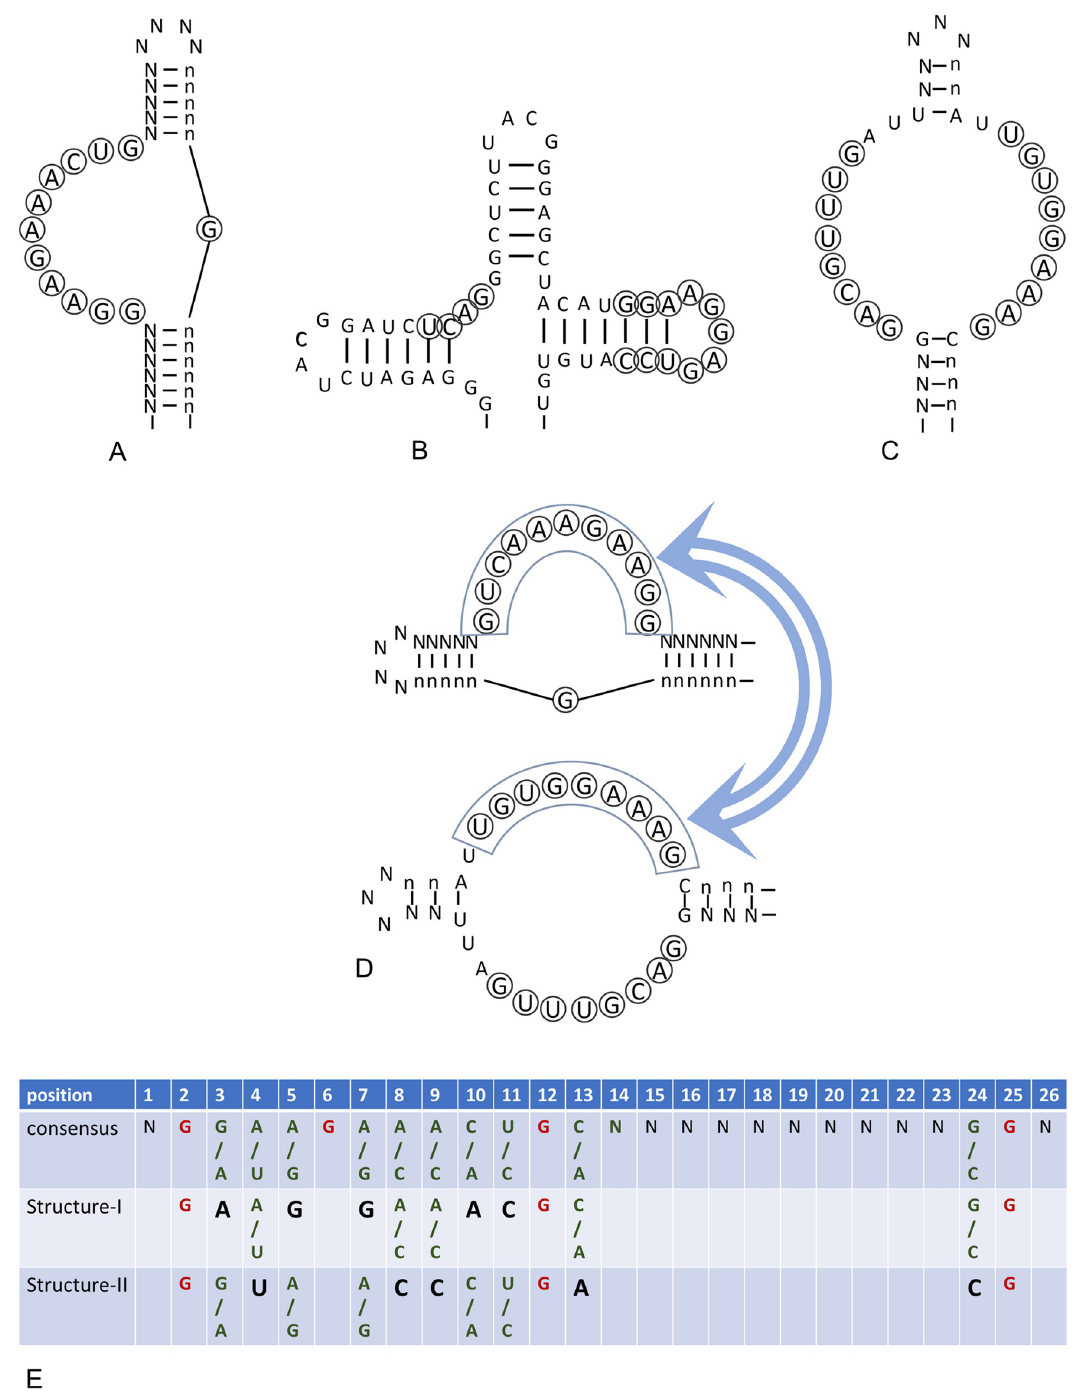
Fig 4. General idea of alternative structures of aptamers binding the same ligand and its specific implementation scheme for the BioRS function. (A-) Three structures of aptamers binding to ATP that differ in their sequence and secondary–tertiary structure. The first structure (structure-I) (Sassanfar-Szostak motif) we will name as a “rod” (A). Second structure (structure-II) will be referred to as a “cloverleaf” (B) [93]. () One more version of an aptamer binding ATP [92]. (D) Consensus sequences of (A) and (C), critical to the recognition and binding of a ligand, in spite of their general similarity, differ to such extent that it is infeasible to transit from one to the other by a series of mutations not losing the aptamer functionality (sequences similar in both versions are framed and marked by double-headed arrows). (E) Single- and double-valued loci in our simplified version of the aptamer with alternative structures. Single-valued nucleotides, necessarily present in both structures, are given in red, those present in one of the alternative structures in black. The other positions are arbitrary. See text for